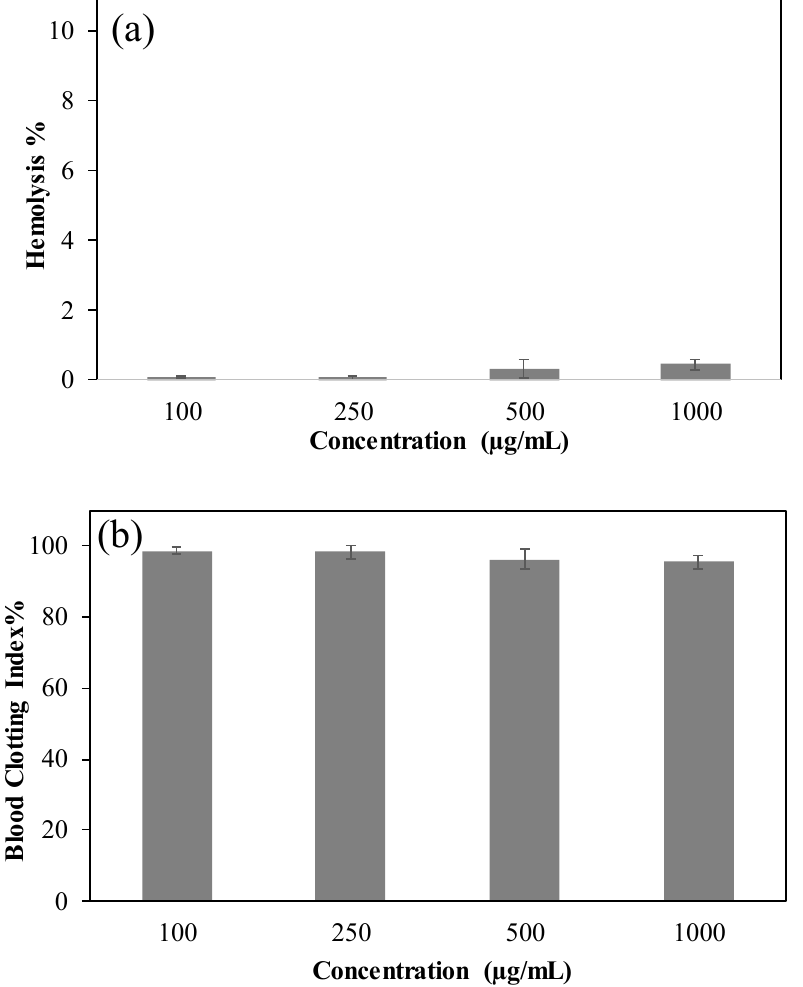
Figure 4. ( a ) hemolysis, and ( b ) Blood Clotting Index of p(Gly) particles at different concentration (100–1000 µg/mL).